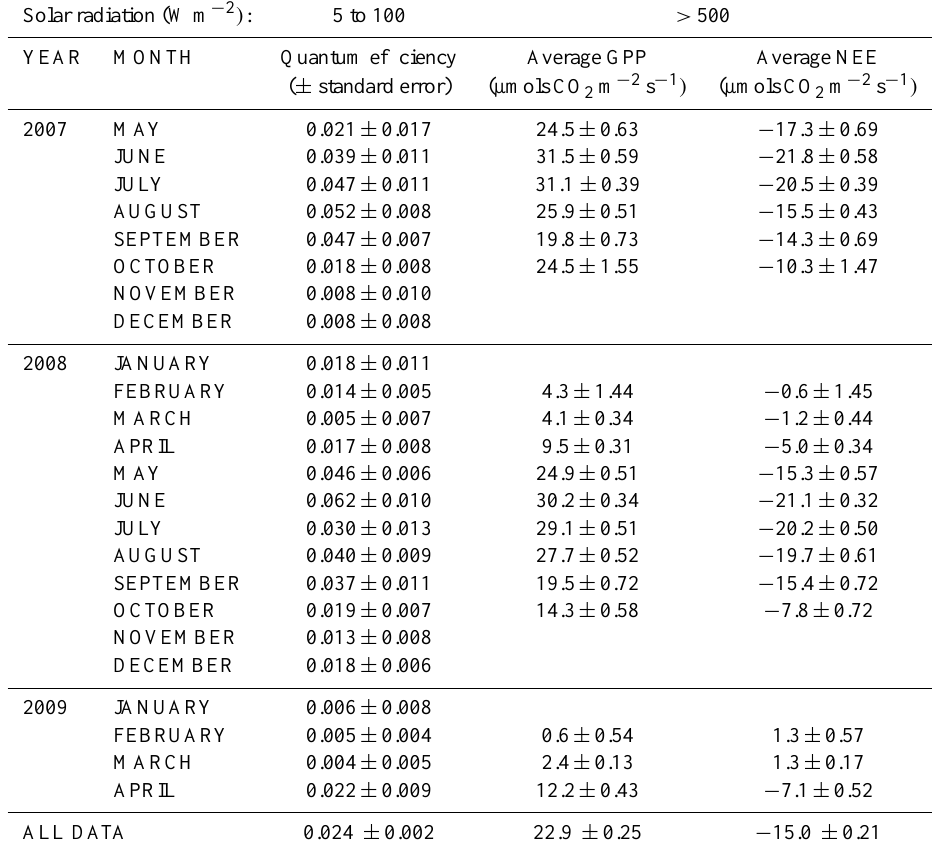
Table 3. Monthly calculations for light use efficiency in Wytham Woods. Quantum efficiency is in units of mols CO 2 per mol of absorbed photon. Blanks indicate too few data to generate quantum efficiency estimates via linear regression. Solar radiation (Wm − 2 ) : 5 to 100 >